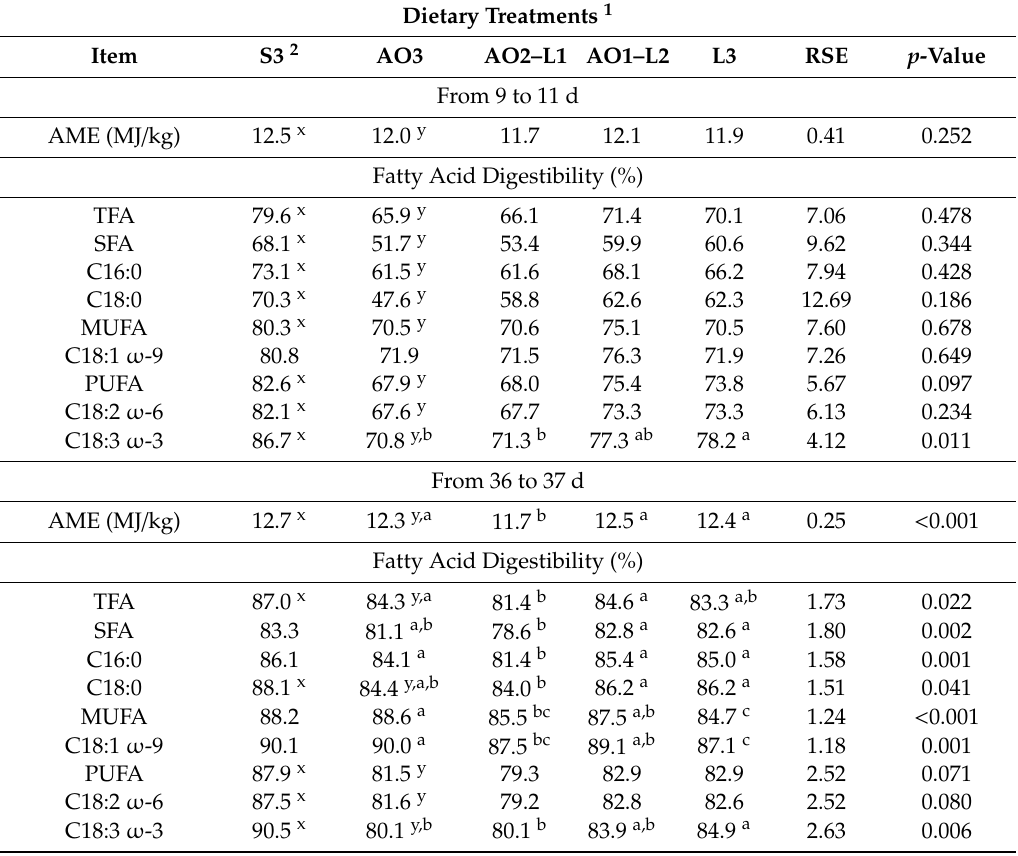
Table 8. Feed apparent metabolizable energy value and fatty acid digestibility of starter and grower–finisher broiler chicken diets according to added fat sources (Experiment